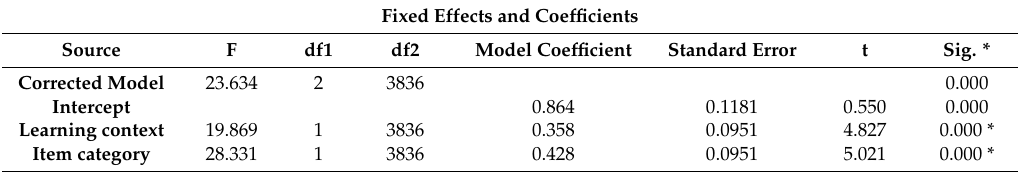
Table 3. Overview of main effects from binomial logistic regression across all participants.